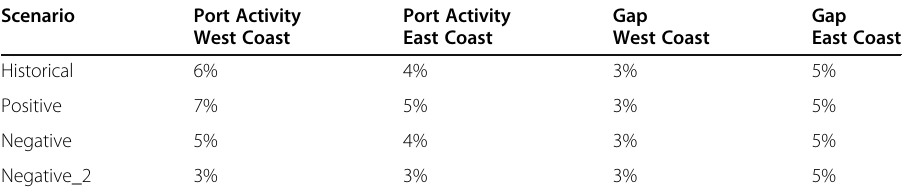
Table 3 Assumptions applied to the estimations Scenario